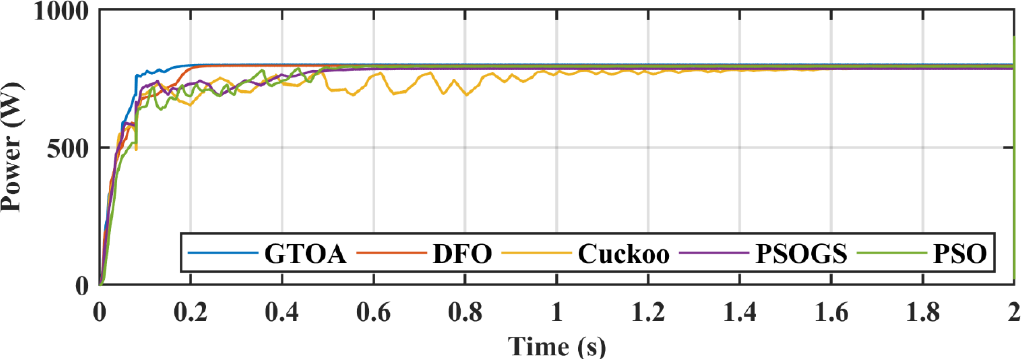
Figure 21. Comparison of power of GTOA.